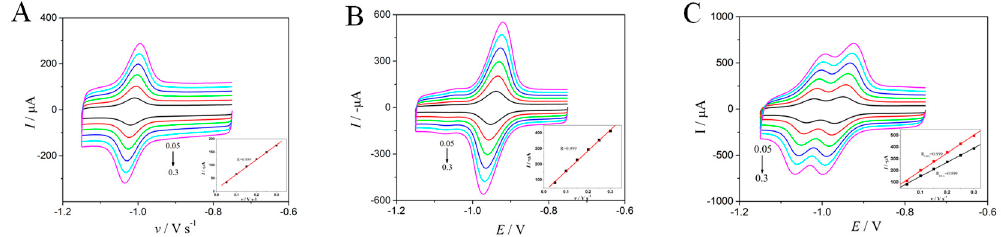
Figure 4. CVs of 1.0 µ mol / L OLA ( A ), CBX ( B ), and OLA and CBX ( C ) on MWCNTs − OH / CMK − 8 modified electrode with different scan rate from 0.05 to 0.3 V s − 1 , the inset is the dependency of peak current with respect to the scan rate.